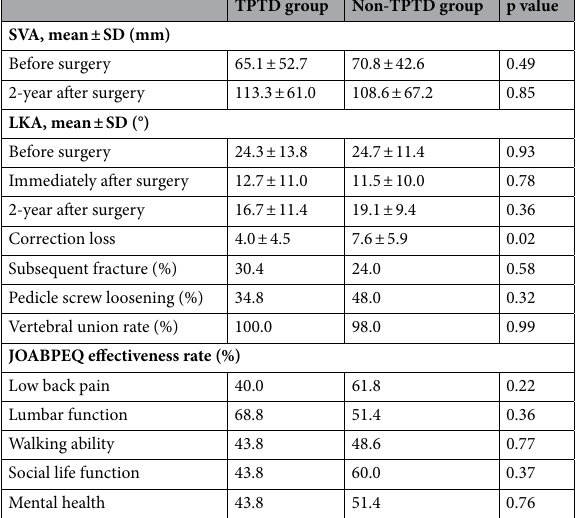
Table 2. Comparison of outcomes. SD standard deviation, SVA sagittal vertical axis, LKA local kyphosis angle, JOABPEQ Japanese Orthopaedic Association Back Pain Evaluation